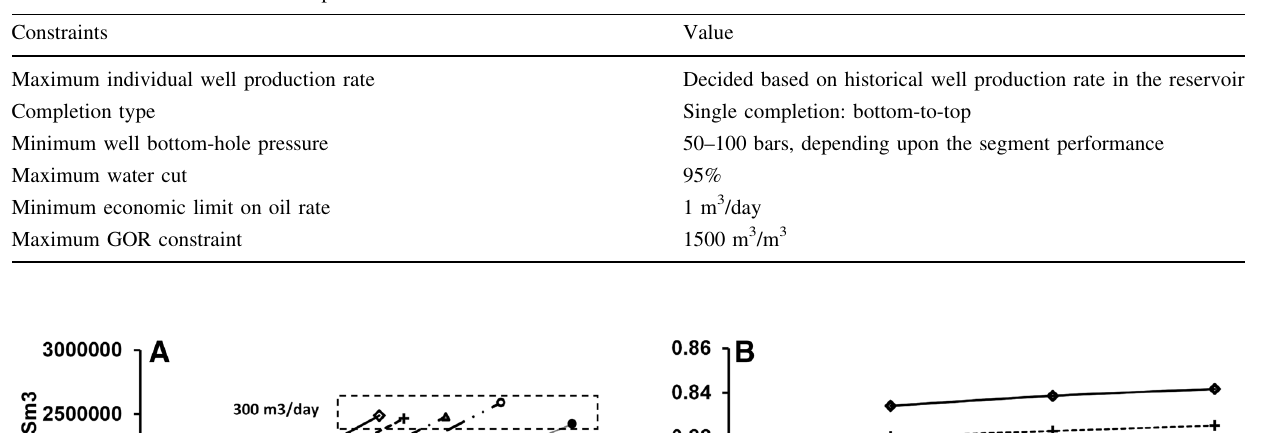
• Figure 10b As rate is increased from 200 to 300 m 3 /day, water cut increases for different horizontal lengths. • Figure 10c, d As assigned liquid rate is increased from 200 to 300 m 3 /day, cumulative oil production increases for every horizontal length. It can be seen that cumulative oil is maximum in case of 800 m of either horizontal length, which decreases on increasing or decreasing horizontal length.